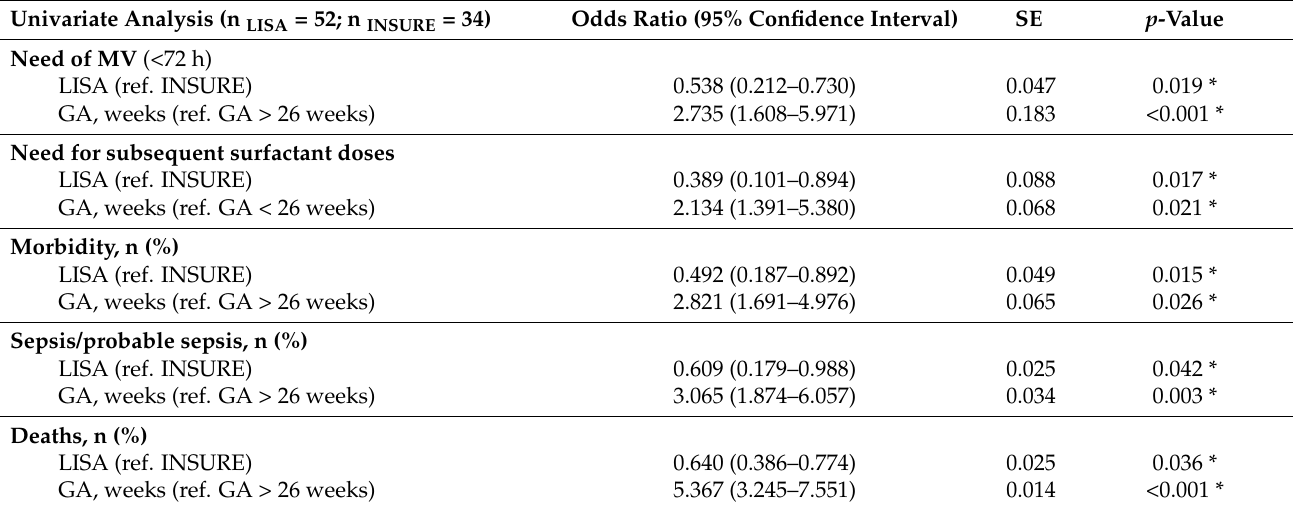
Table 5. Univariate logistic regression for